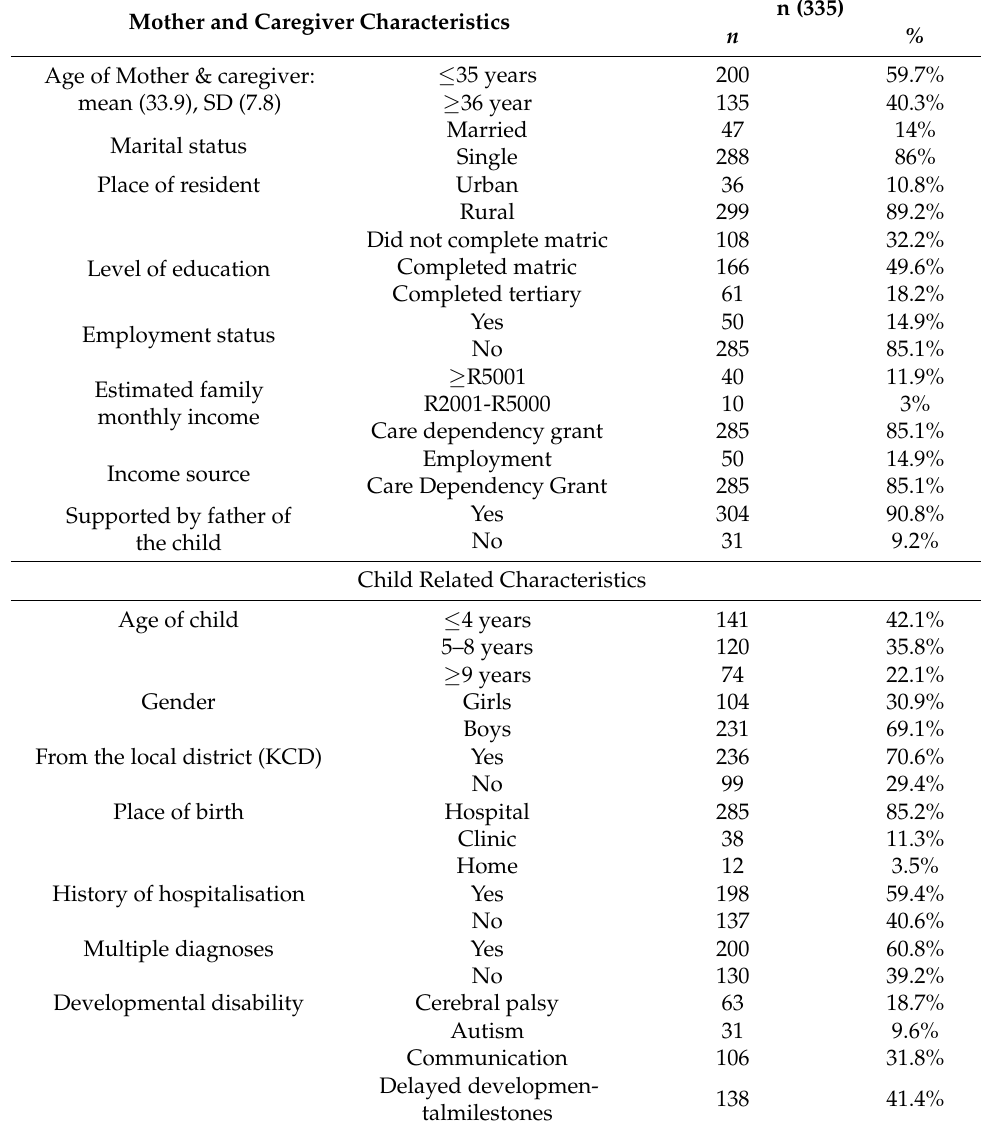
Table 1. Demographic characteristics of the